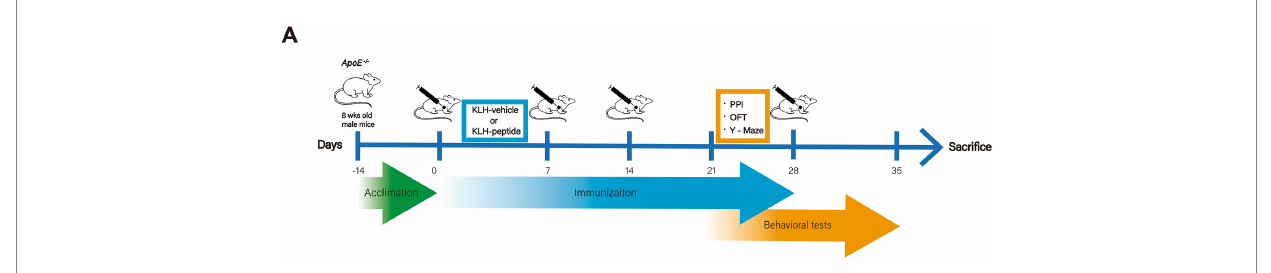
FIGURE 1 Experimental design. Schematic demonstration of the experimental workflow. ApoE − / − (10 weeks) mice were immunized with S protein-derived peptide (coupled with KLH, KLH-peptide) or KLH (KLH-vehicle) only on days 0, 7, 14 and 28. Behavioral tests started on day 23 for the Y-Maze tests, on day 25 for the open field test (OFT), and on day 30 for prepulse inhibition